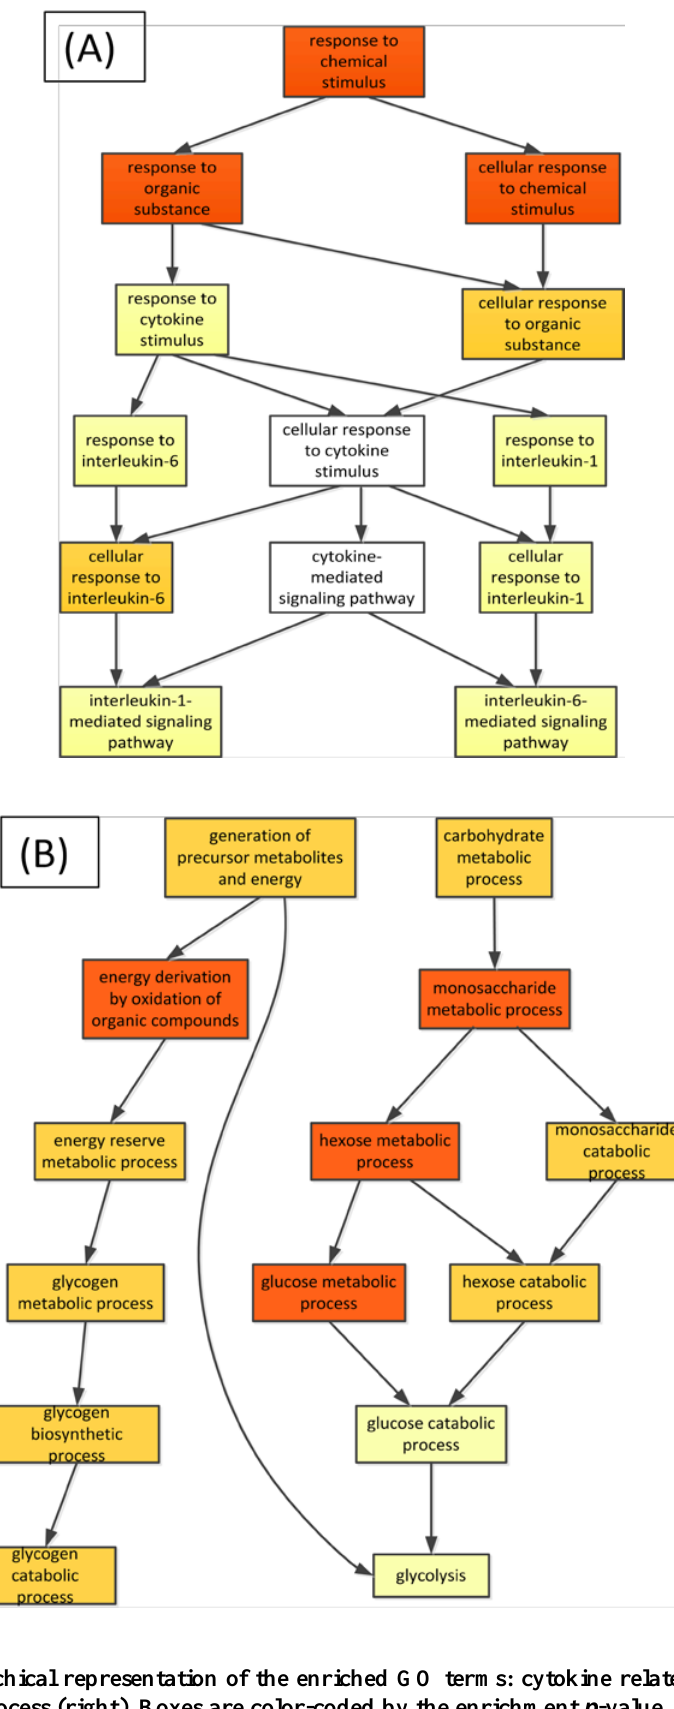
Figure 5: Hierarchical representation of the enriched GO terms: cytokine related process (left), and metabolic process (right). Boxes are color-coded by the enrichment p -value, where red is the most significant ( p <1×10 -9 ) and yellow is the least significant ( p >1×10 -3